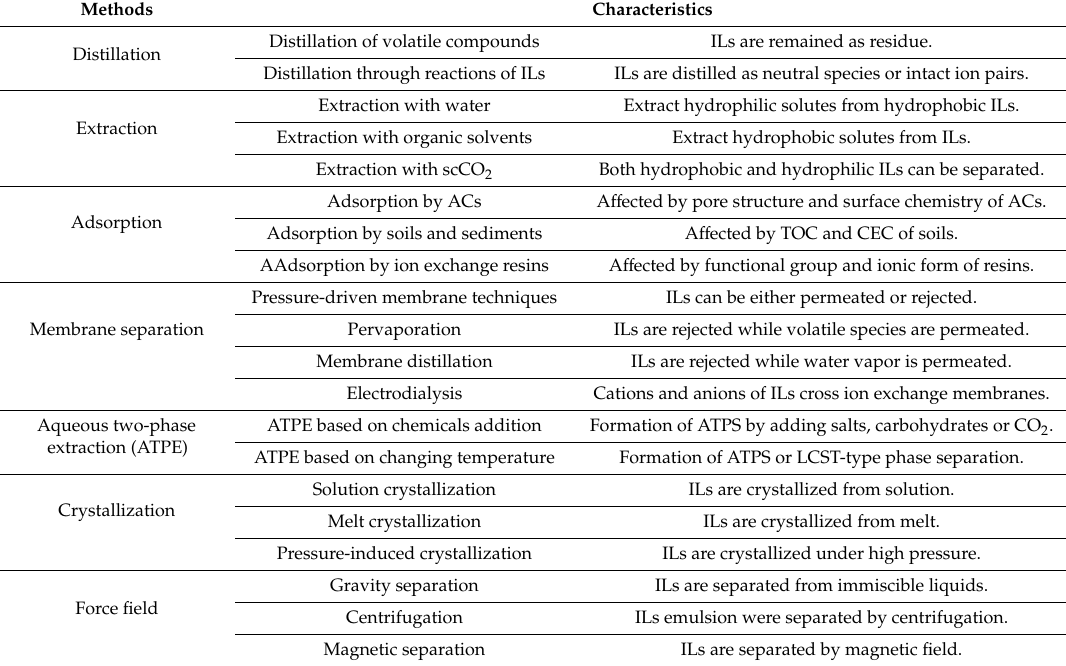
Table 4. Comparison of ionic liquids recovery methods. Adapted with permission from